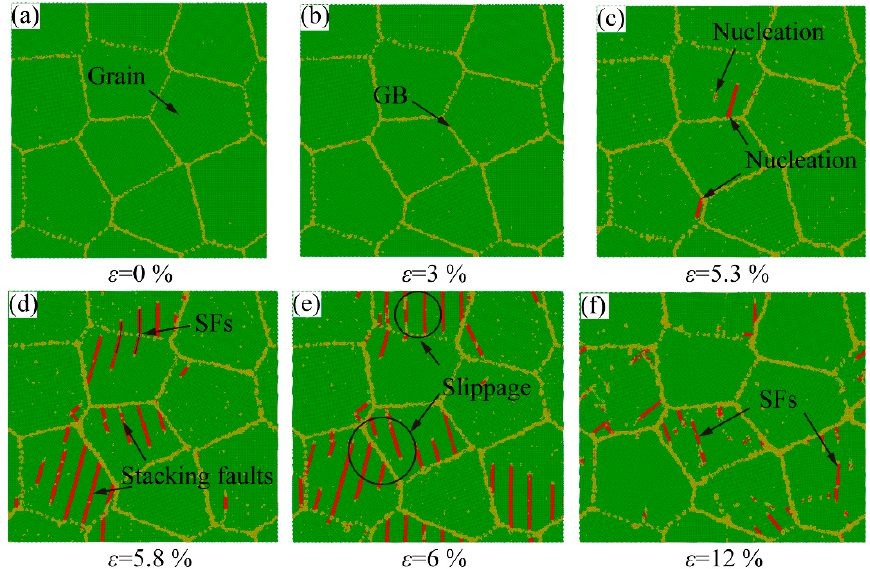
Figure 16. The atomic configurations of polycrystalline Al-2%Mg alloy with grain size D = 16.0 nm at different strains during 300 K tensile simulation. ( a , b ) the elastic deformation stage. ( c − f ) the dislocation nucleation dominates the plastic deformation.